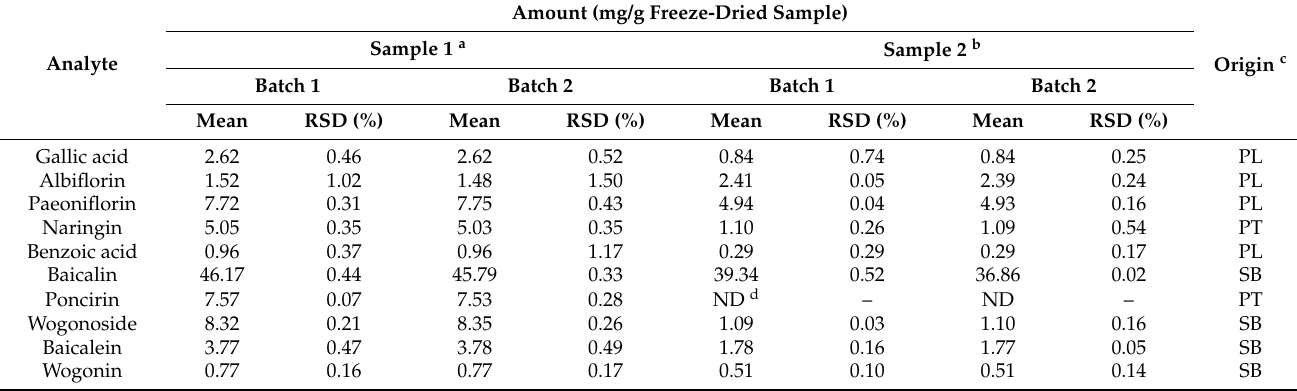
Table 4. Concentrations of the 10 markers in the DSHT samples determined with the HPLC–DAD assay ( n =